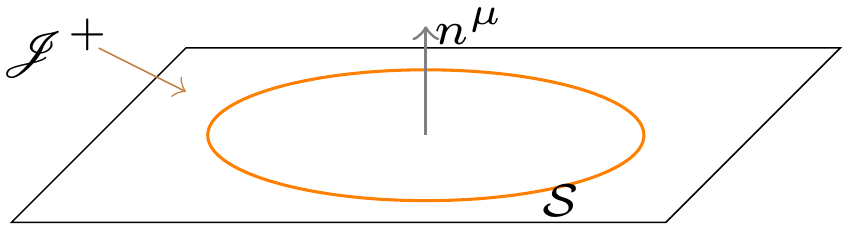
Figure 3. This is a schematic representation of J + when Λ > 0, where n µ is timelike and normal to J + , and S represents a cut with spherical topology. As usual, one dimension is suppressed. The topology of J is not fixed, and the manifold can be R 3 , R × S 2 , S 3 , or even S 3 \ { p 1 , . . . , p n } with n > 2; see the main text. If, for instance, the topology is S 3 , the shown schematic representation should be understood as a stereographic projection onto Euclidean space. Thus, the best way to imagine J + when Λ > 0 is as S 3 , possibly with a number of points